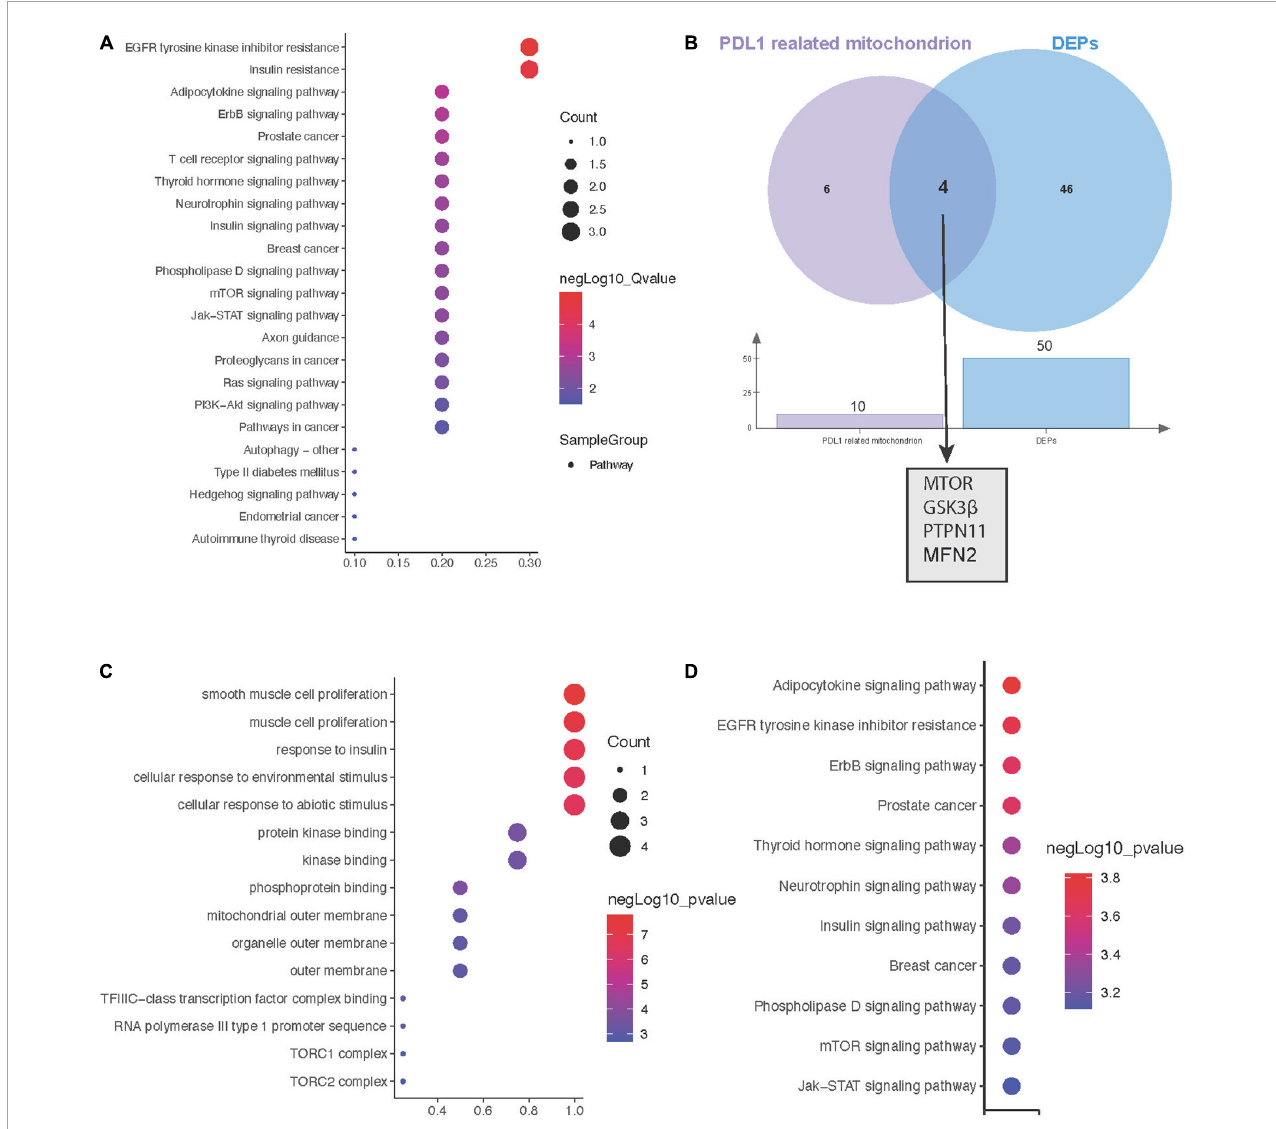
FIGURE4 Hub genes between mitochondrial metabolism and immune checkpoint inhibitors (ICI)-related myocarditis. (A) Kyoto encyclopaedia of genes and genomes (KEGG) enrichment analysis of PD-L1-related proteins. (B) Screening for coexpressed proteins between PDL1 and mitochondria-related proteins in differentially expressed proteins (DEPS). (C) Biological process (BP) enrichment analysis of hub proteins. (D) KEGG enrichment analysis of hub